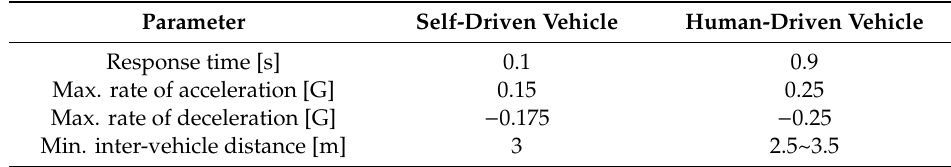
Table 5. Parameter values that cause di ff erences in operations between self-driven and human-driven